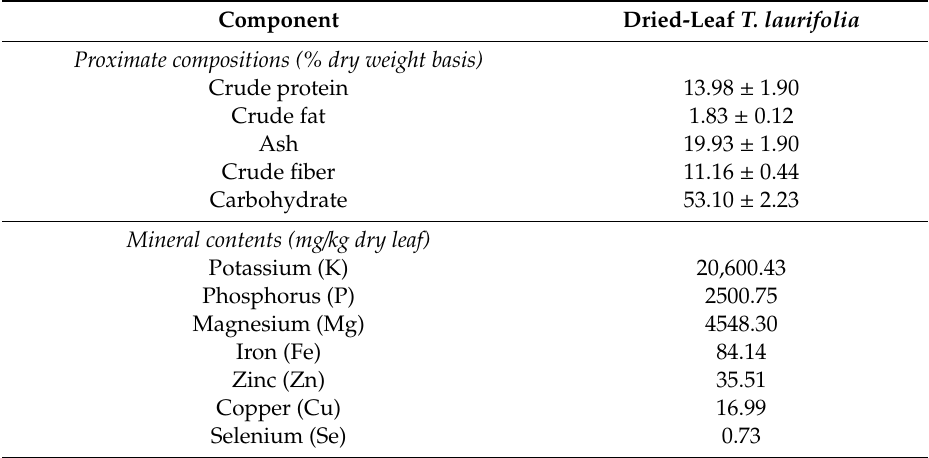
Table 1. Proximate composition and mineral contents of T. laurifolia dried